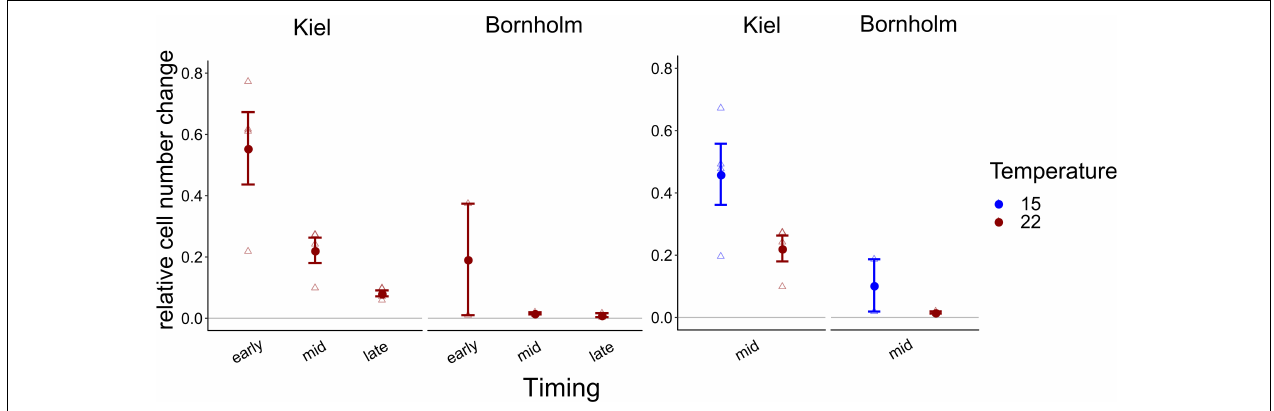
FIGURE 4 | Overall relative increase in cell numbers on carbon normalized by the number of sources on which we found positive growth is shown here: in the left panel the growth at 22 ◦ C (red) at early, mid and late exponential phase is shown, whereas in the right panel relative growth at mid exponential phase at 15 (blue) and 22 ◦ C (red) degrees is shown. All points show mean ± 1 SE including n = 4 and n = 2 for Kiel and Bornholm, respectively. Triangles present the overall growth on organic carbon per ecoplate of each experimental unit.